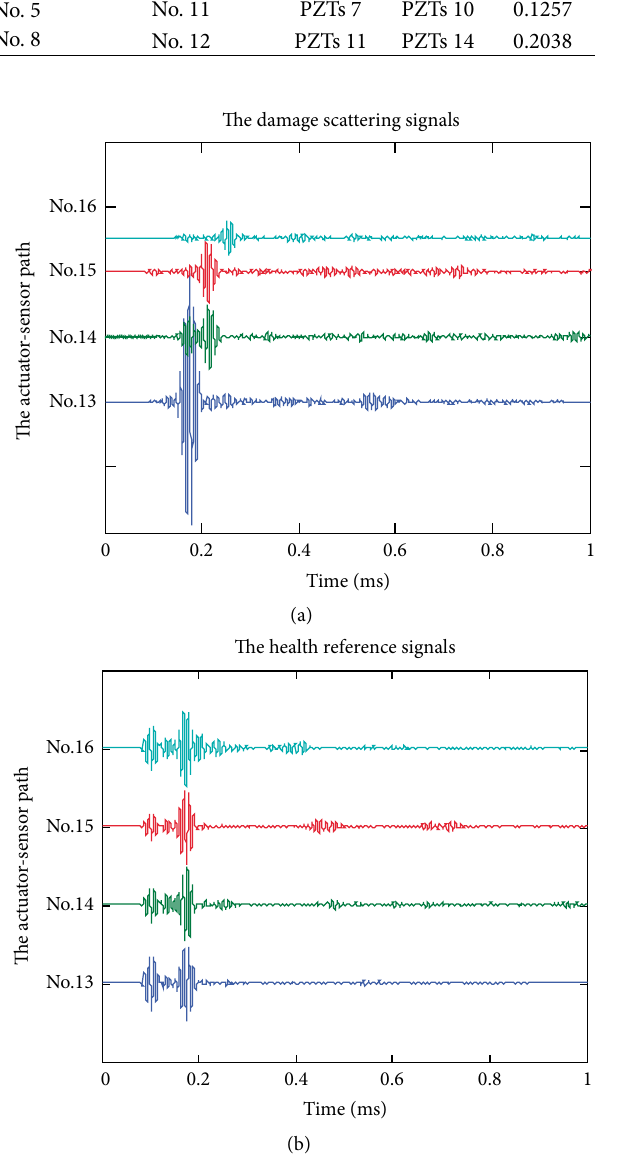
Figure 11: The damage scattering and health reference signals of the remaining actuator-sensor paths of the damage subarea. (a) The damage scattering signals; (b) The health reference signals.